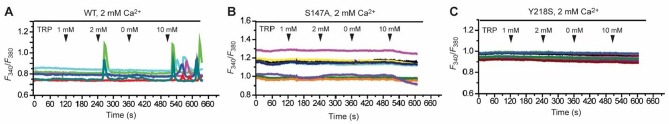
Effect of various concentrations of L-Trp (1, 2, 0, 10 mM) on intracellular Ca2+ mobilization in the presence of 2 mM extracellular Ca2+.(A) Wild-type (WT) CaSR. (B) S147A mutant. (C) Y218A mutant.